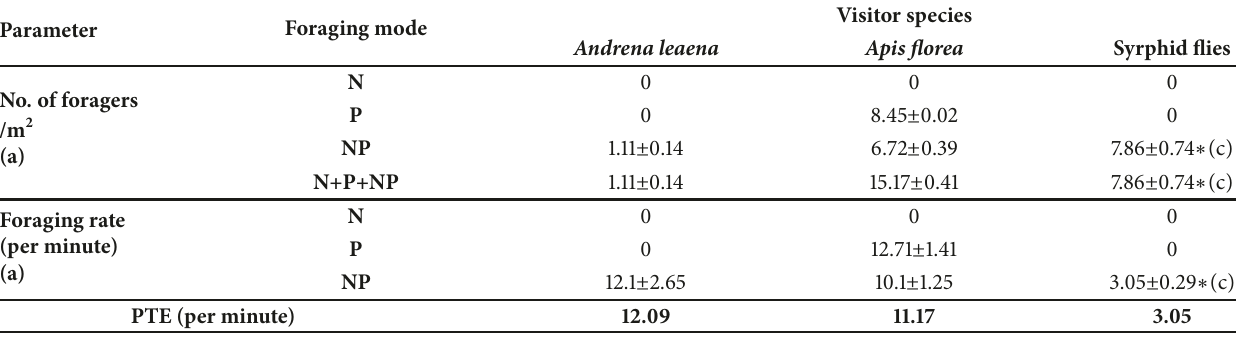
Table 7: Foraging modes, number of foragers, foraging rates, and pollen transfer efficiency of different flower visitors of carrot ( Daucus carota ).